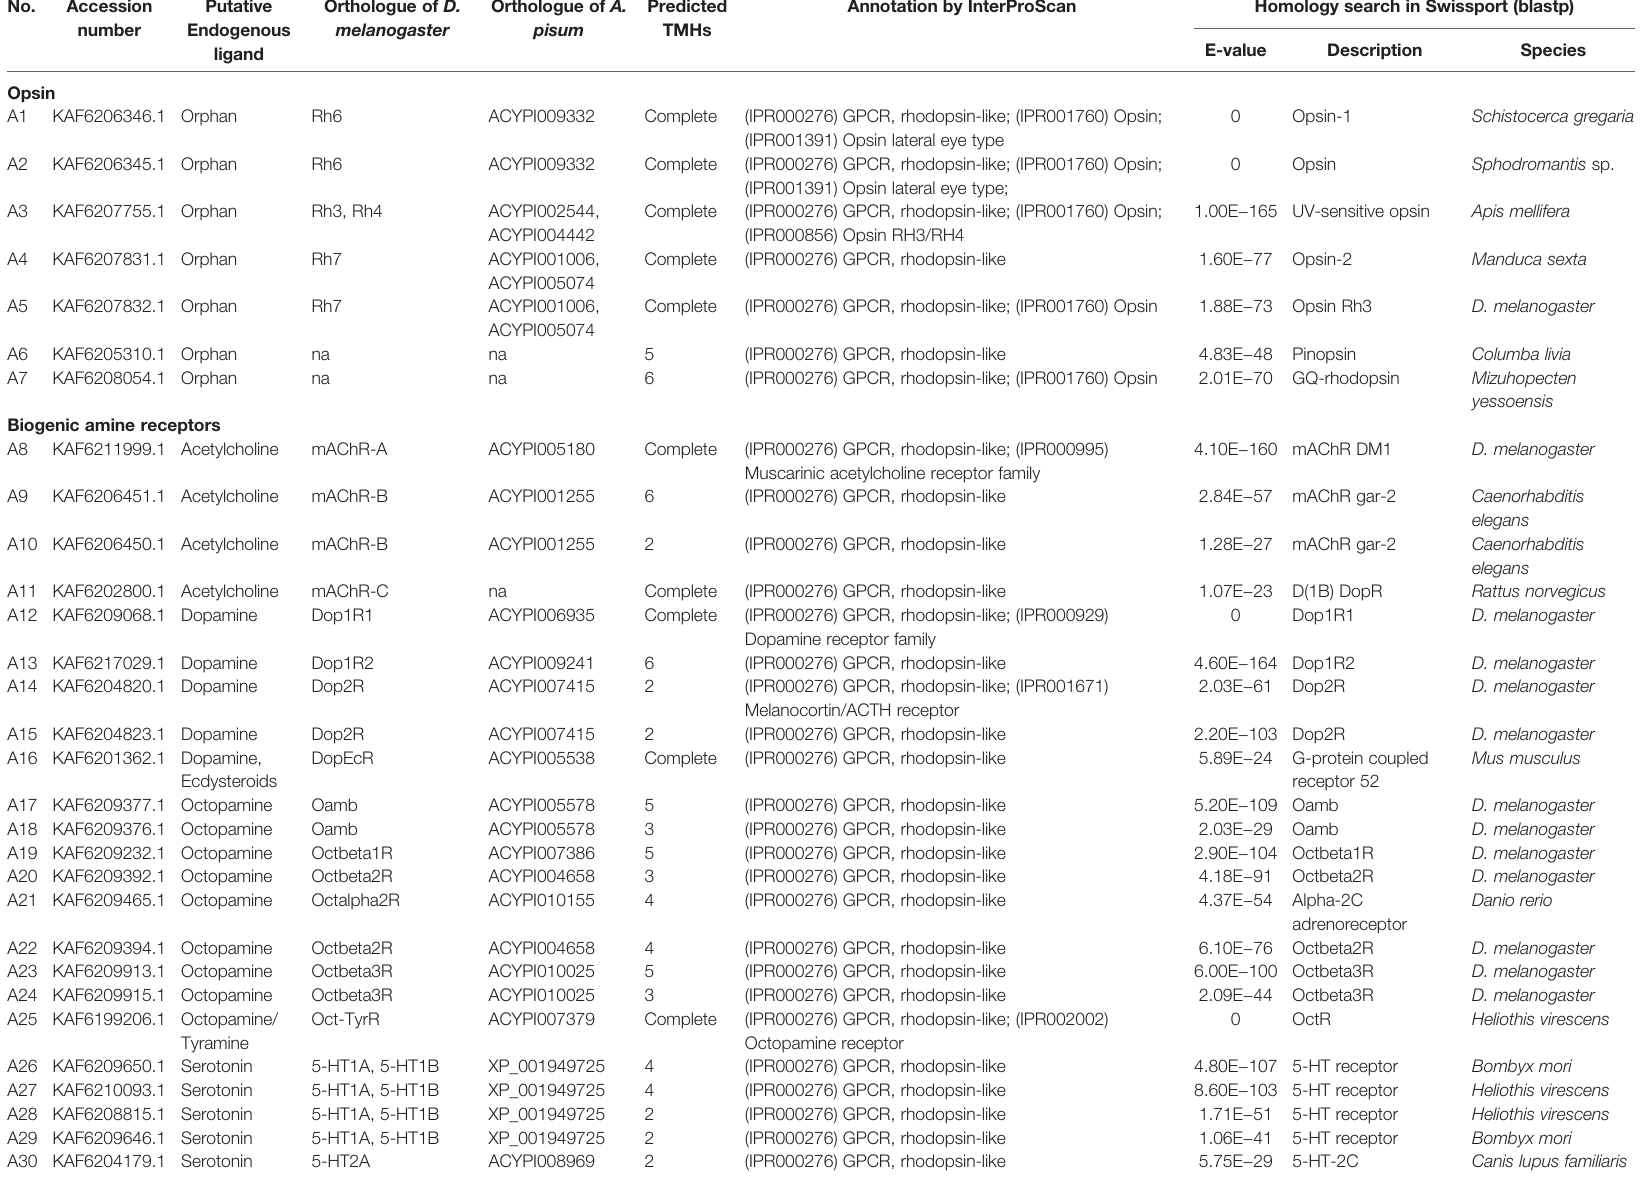
TABLE 1 | Opsin and biogenic amine receptors in A.